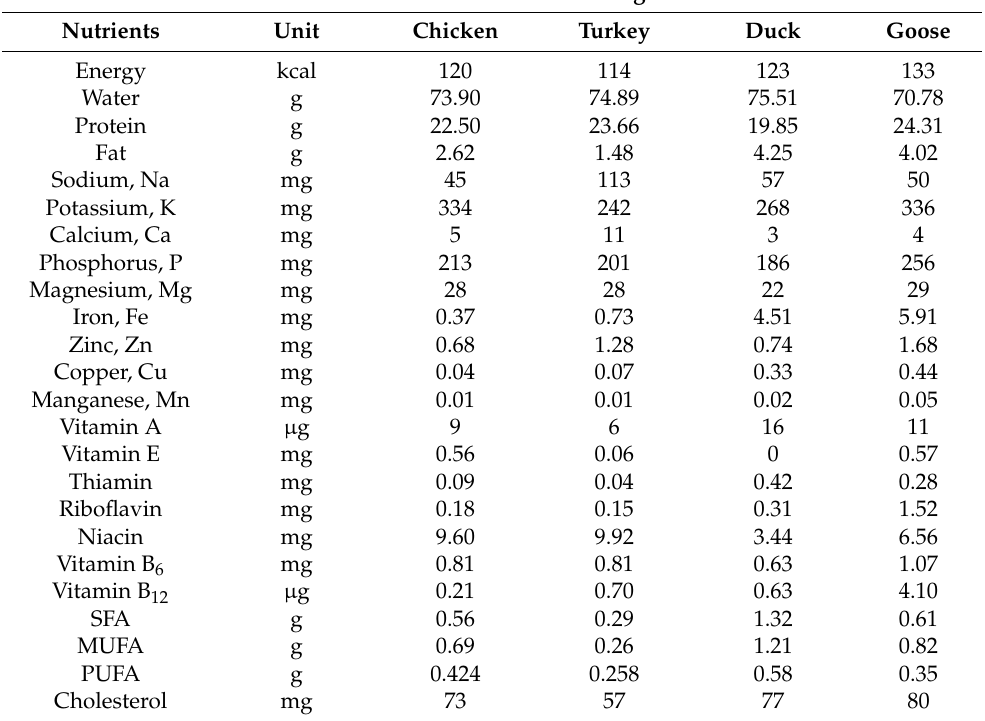
Table 1. The nutritional value of the breast muscles (without skin) of different species of poultry per 100 g of raw meat